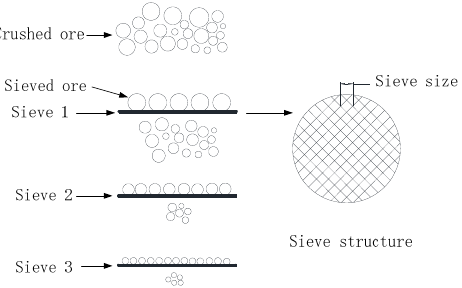
Figure 6. Ore screening process in the drop weight test.